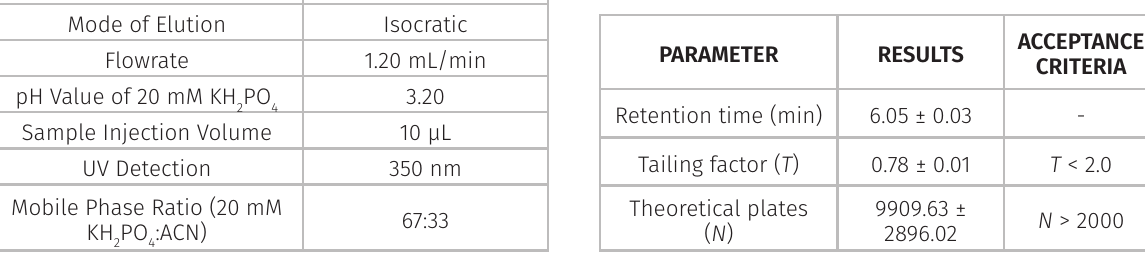
Table II. Performance parameters for the optimized chromatographic